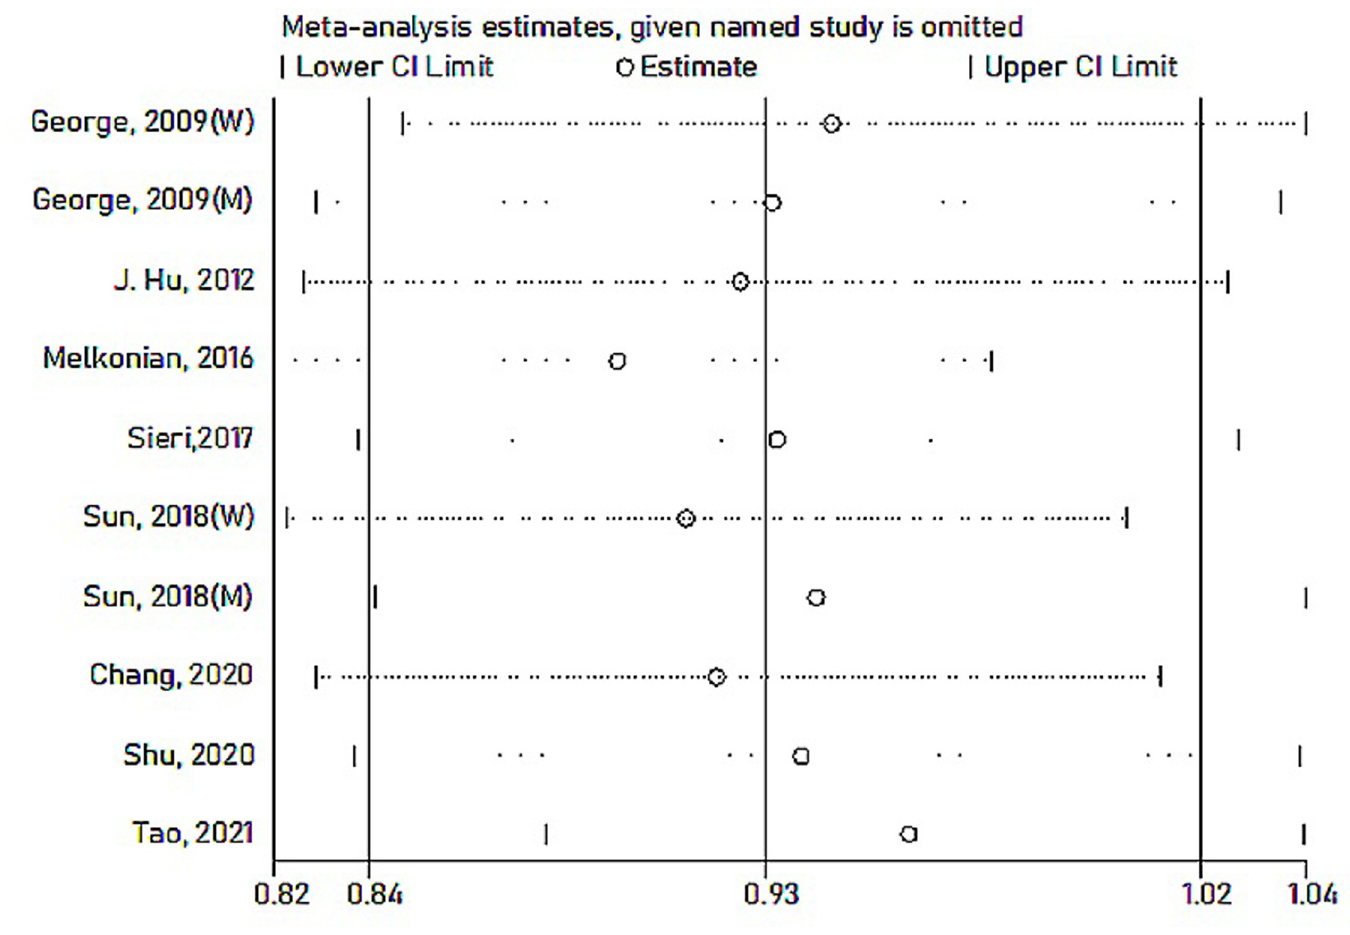
Fig 8. Sensitivity analysis for the association between GL and lung